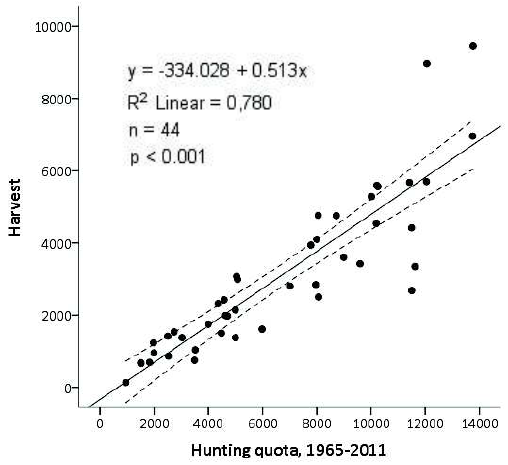
Figure 3. The regression with 95% confidence interval of harvest on hunting quota for 1965 -2011 for the Nor- wegian Hardangervidda wild reindeer herd, excluding 1971,1972 and 2004 when no hunting occurred.